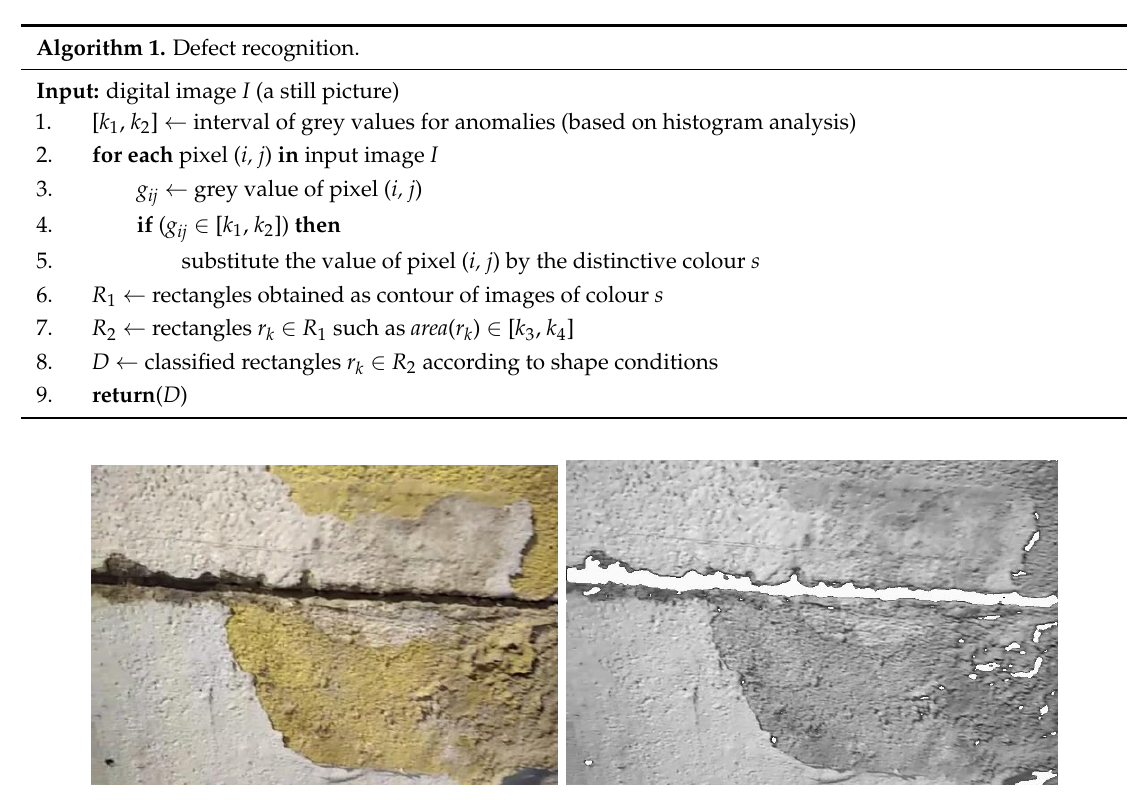
Figure 5. Example of original versus resulting image after flaw separation.